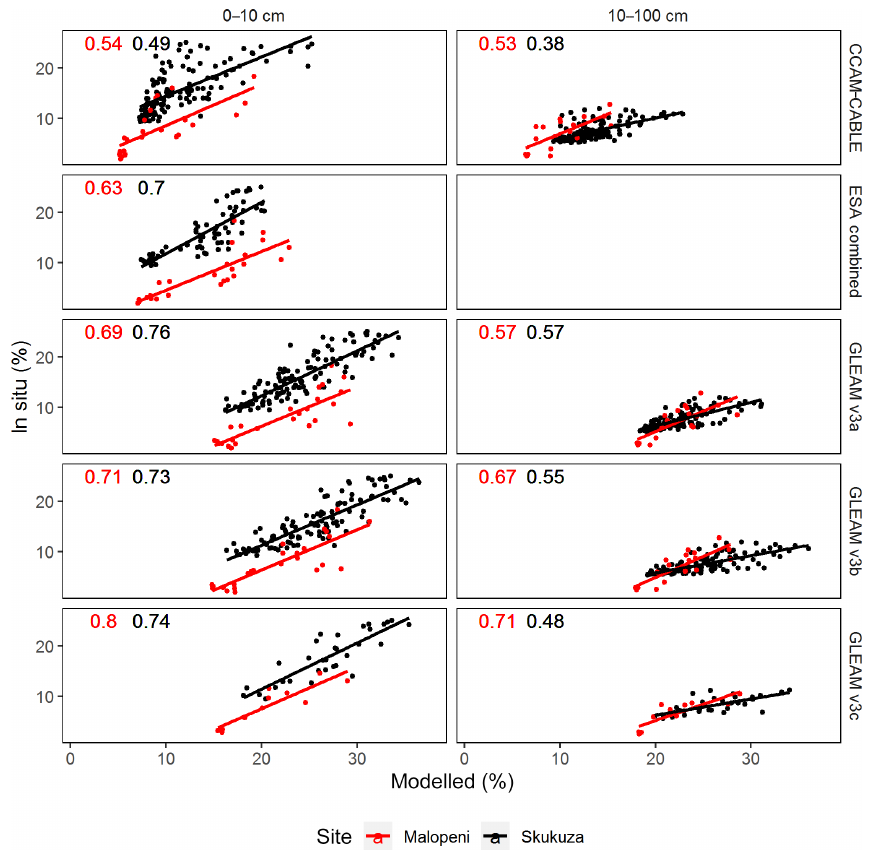
Figure B1. Quantitative monthly comparison between soil moisture products and observations at Skukuza (black; 2001–2014) and Malopeni (red; 2008–2013), at the surface (0–10cm) and root zone (10–100cm), using the coefficient of determination ( R 2 ) depicted by the numbers in the top left of the